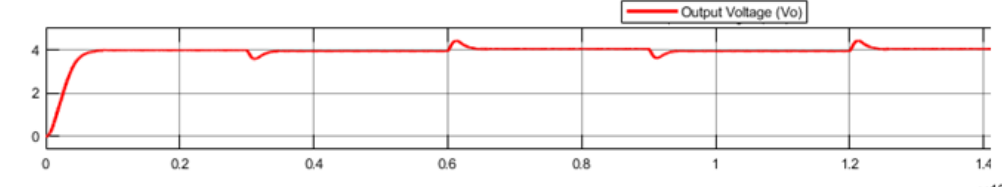
Figure 14. Converter output voltage response during input disturbances in the presence of radiation fault injection (ex- periment 1).